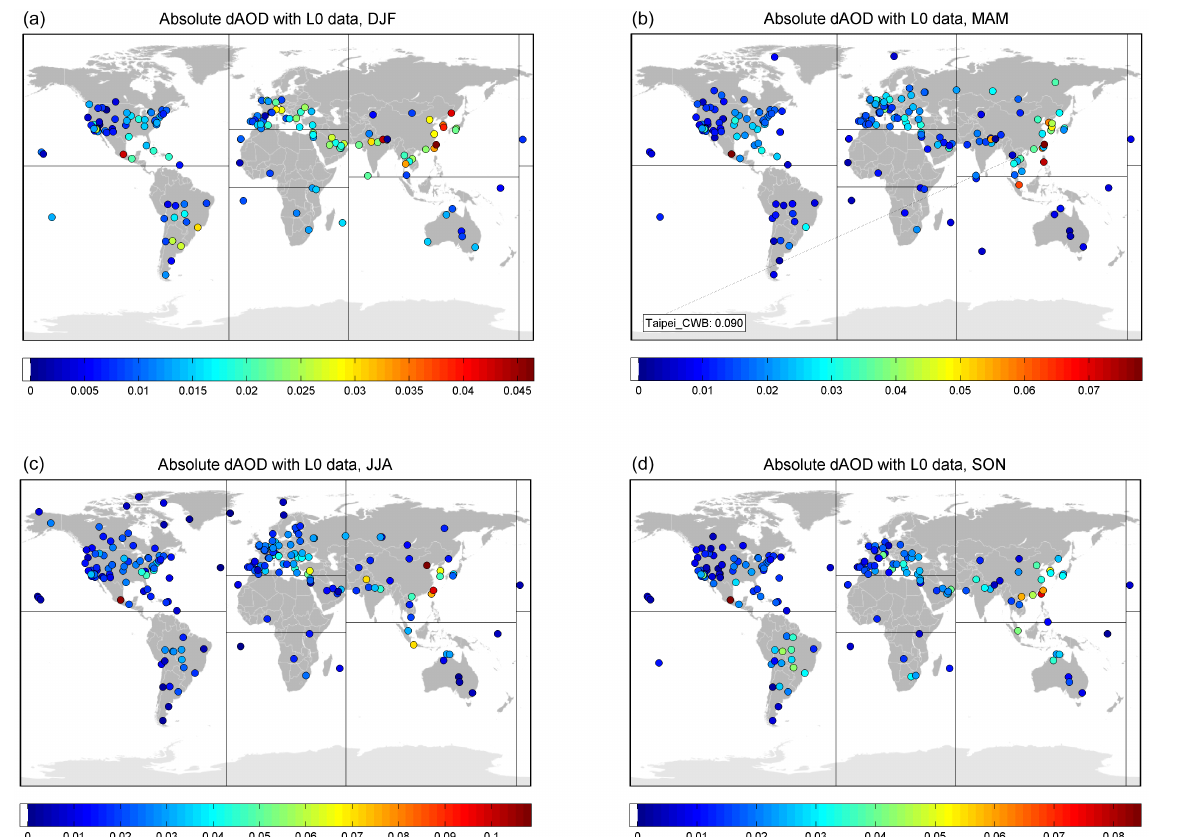
Figure 2. The difference between cloudy-sky and clear-sky (between L0 and L2) fine-mode AOD for different seasons: DJF (a) , MAM (b) , JJA (c) , and SON (d)